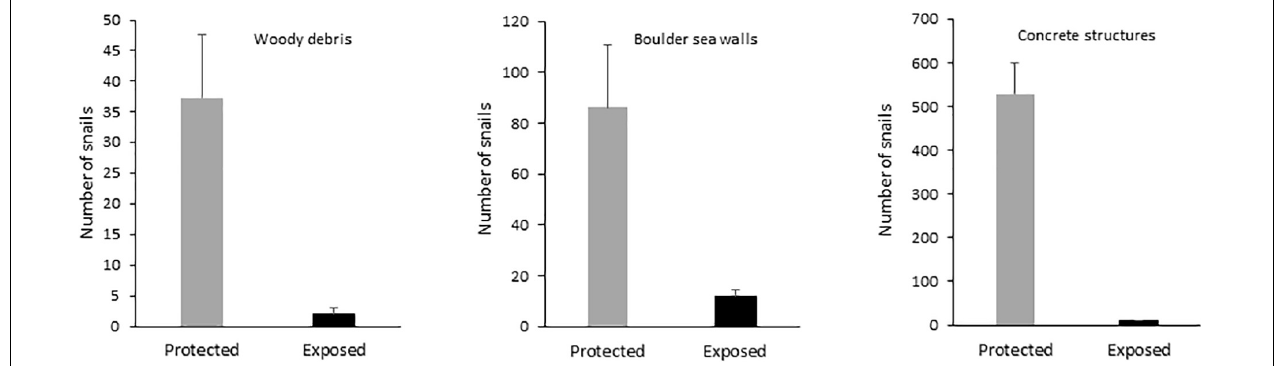
FIGURE 4 | Comparison of the number of Littoraria angulifera in wave-protected and wave-exposed positions in woody debris, boulder seawalls and concrete structures in the Urabá Gulf, Antioquia, Colombia. Error bars are standard